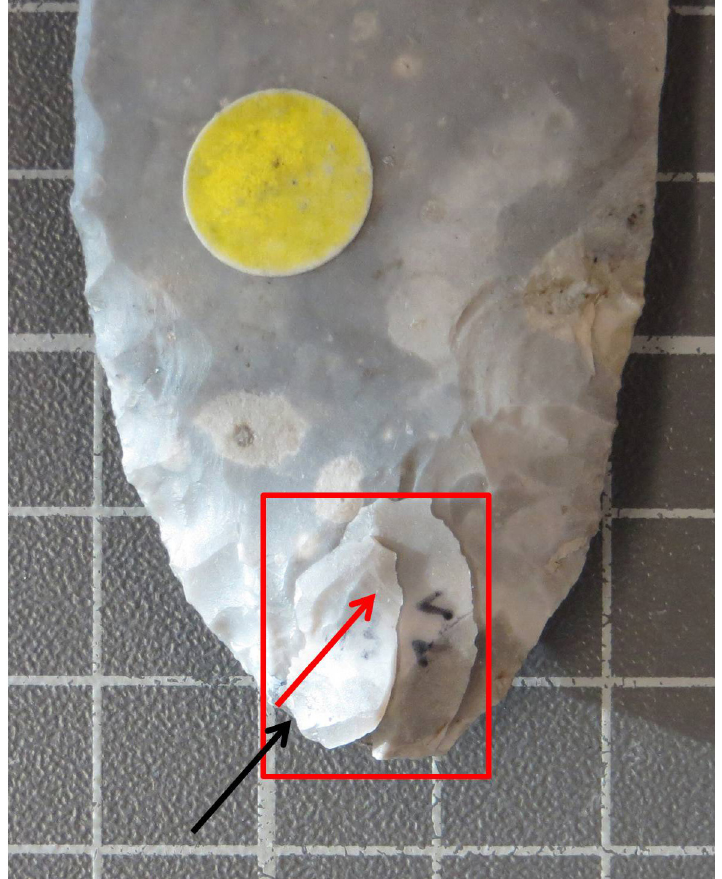
Figure 8. Blade-point 4.2, flake v3 with the black arrow showing direction of the removal blow and the red arrow the dorsal scar pattern (photographs by the author). Gridlines on this image are 10mm